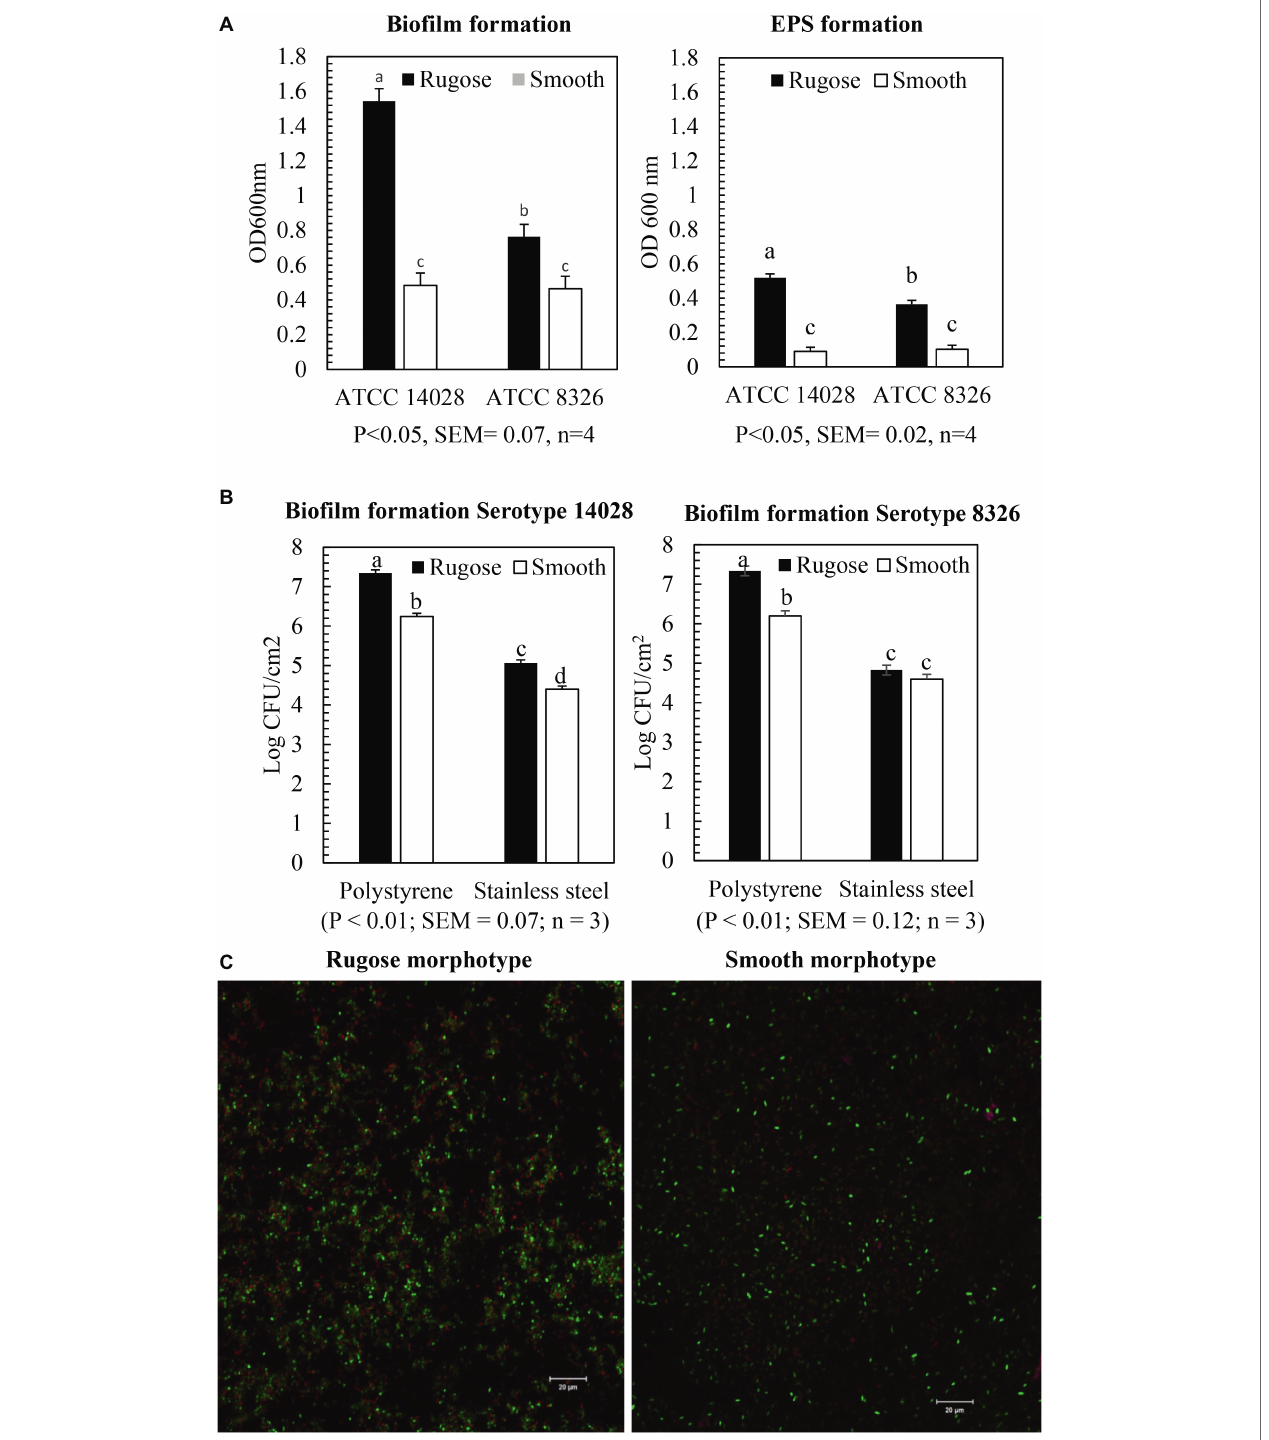
FIGURE 2 | Biofilm and EPS formation of two morphotypes of S. Typhimurium (ATCC 14028) and S. Heidelberg (ATCC 8326) in 48 h at 25 ° C. (A) Bars represent average OD 600 value of the biofilm and EPS formation on polystyrene surface after staining with crystal violet assay and ruthenium red assay. The black bar represents rugose morphotype and white bar represents smooth morphotype, (B) Bars represent average CFU/cm 2 value of cellular density of the biofilm formation on polystyrene surface and SS surface. The black bar represents rugose morphotype and white bar represents smooth morphotype, and (C) Scanning confocal images of biofilms of S. Typhimurium (ATCC 14028) rugose and smooth morphotypes after 48 h at 25 ° C. Violet color indicates exopolysaccharides, red color indicates protein compounds and green color indicates nucleic